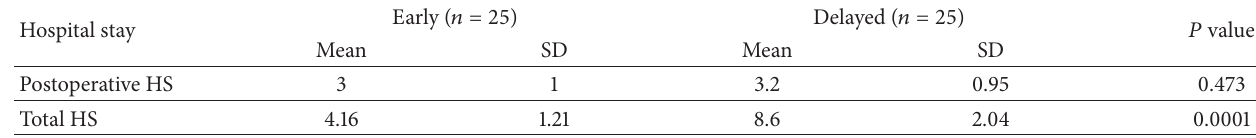
Table 5: Comparison of length of hospital stay in early and delayed group.